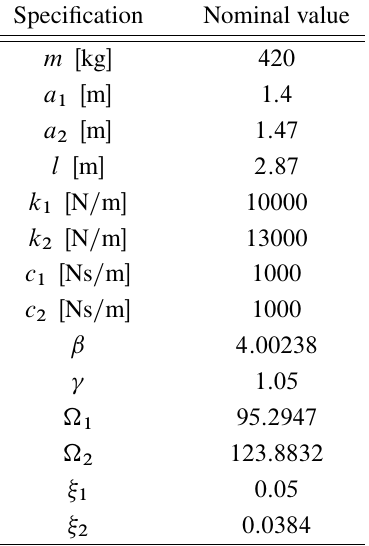
Table 1. Specification of a sample